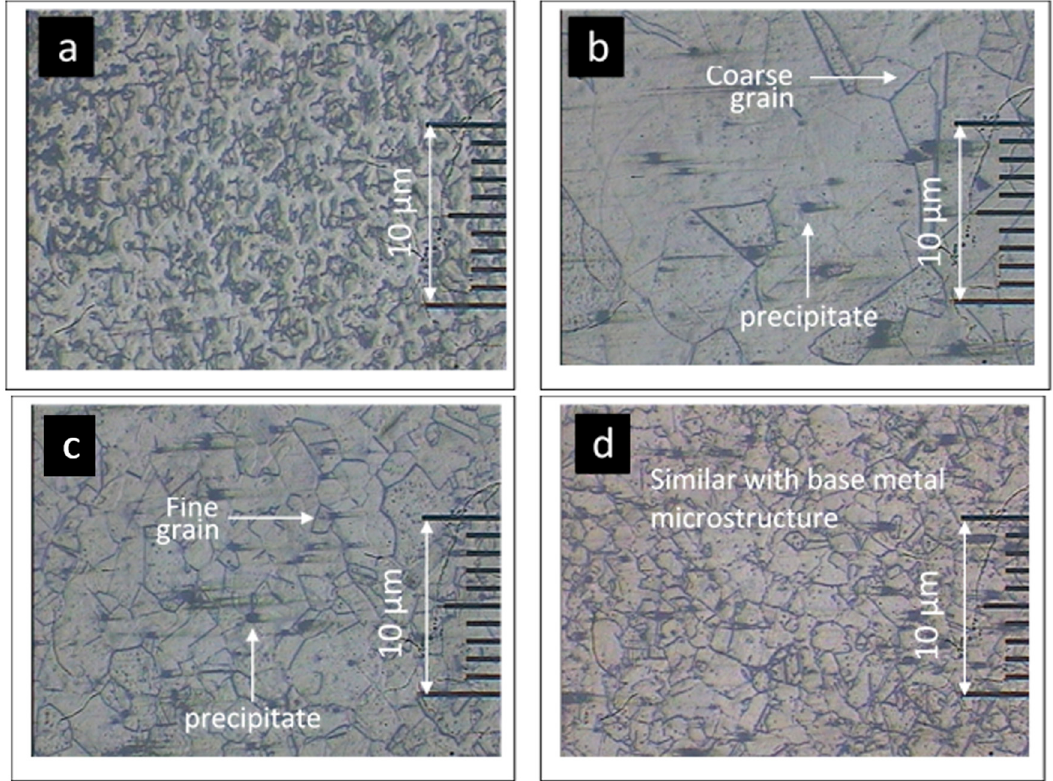
Figure 2. Microstructure of AISI 304 welding. ( a ) fusion zone, notch position at the center of welding; ( b ) high temperature heat afected zone, notch position: 4 mm from the center of welding; ( c ) low temperature heat affected zone, notch position: 5.5 mm from the center of welding; ( d ) unaffected base metal zone notch position: 7 mm from the center of welding.